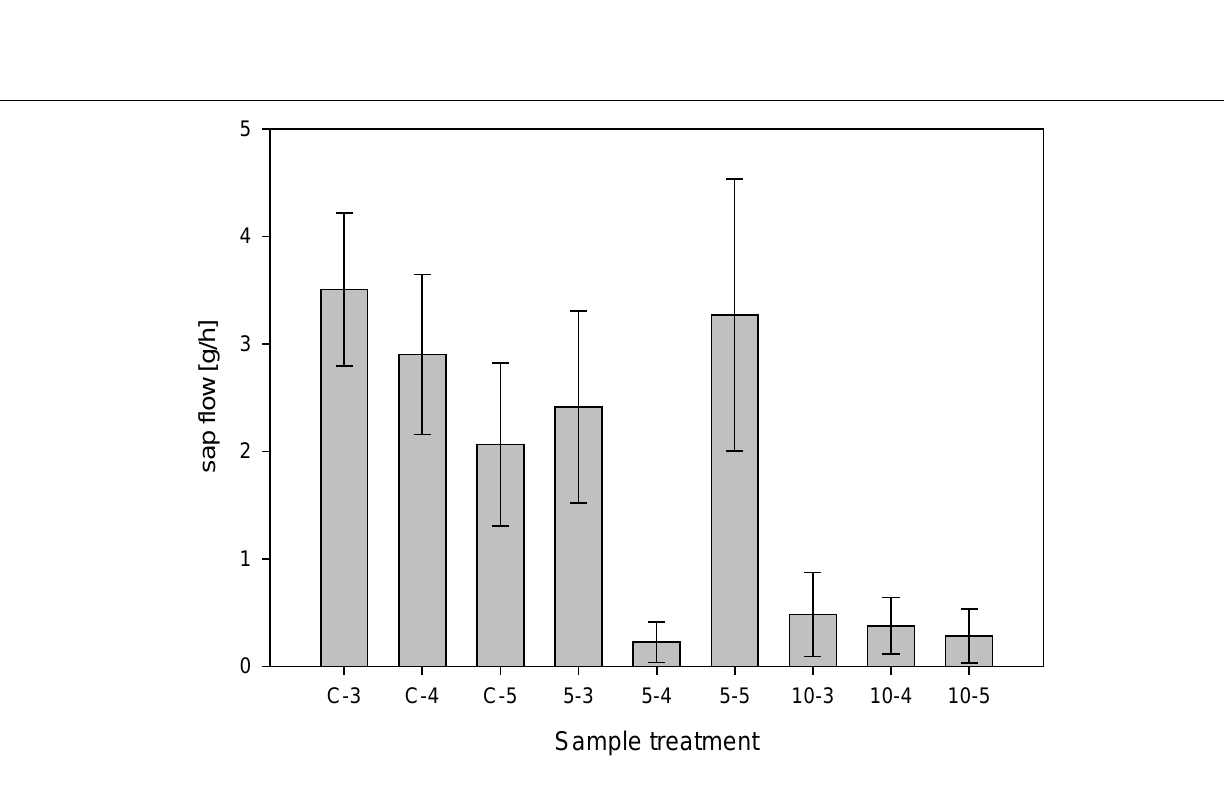
FIGUREA4 | Xylem sap flow of cucumbers subjected to different arsenic treatment: No arsenic (C-x), 5–3: 677 μ g/kg; 5–4: 666 μ g/kg; 5–5: 791 μ g/kg; 10–3: 1405 μ g/kg; 10–4: 1407 μ g/kg; 1405 μ g/kg, ( n = 4).